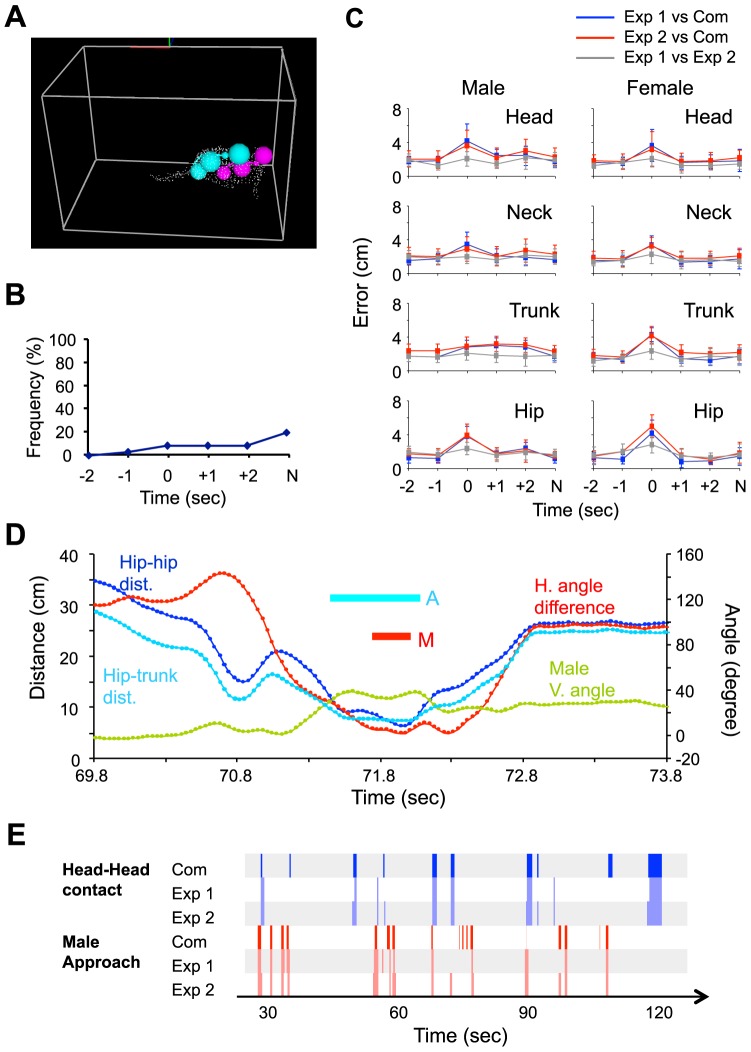
Validation of position estimation during sexual behavior.A: An example of the estimated positions of body parts during sexual behavior. The corresponding movie is available as Movie S2. B: Cumulative frequency of occurrence of significant problems around mounting. Horizontal axis indicates the time from the onset of mounting. N: −2 sec from onset of the next mounting. C: The averaged errors of estimated positions for the head, neck, trunk, and hip of male and females around mounting. Exp 1: the experimenter 1; Exp 2: the experimenter 2; Com: the present system. Error bars: SD. D: An example of the time-course of parameters used for detecting mounting around an occurrence of a mount. Hip–hip dist.: distance between the hips; hip–trunk dist.: distance between the female hip and the male trunk; H. angle difference: angular difference between the horizontal direction of rats; male V. angle: vertical angle of the male rat; A: time period when the male rat mounted, as automatically detected by the 3D system; M: time period when the male rat mounted, as visually observed by the experimenter. E: An example chronogram for the head-head contact event (blue) and the male approach event (red) marked by the present system (Com) and 2 blind experimenters (Exp 1 and 2).